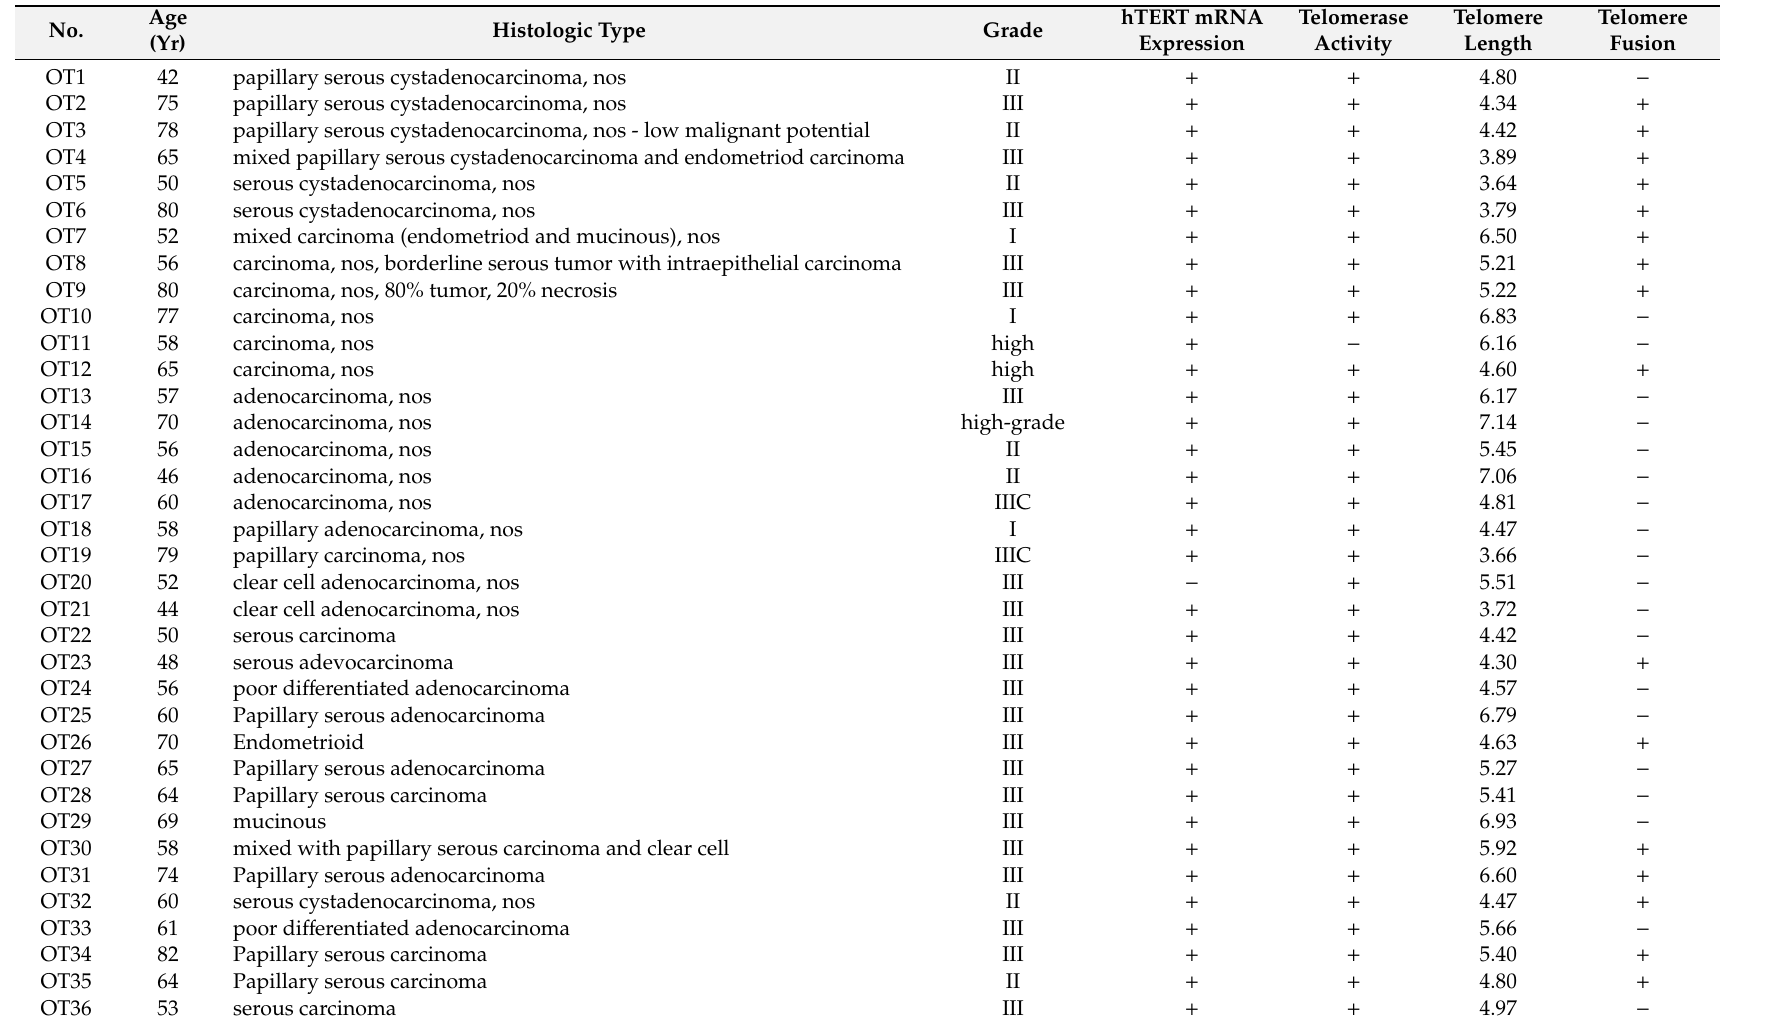
Table 2. Ovarian tumor